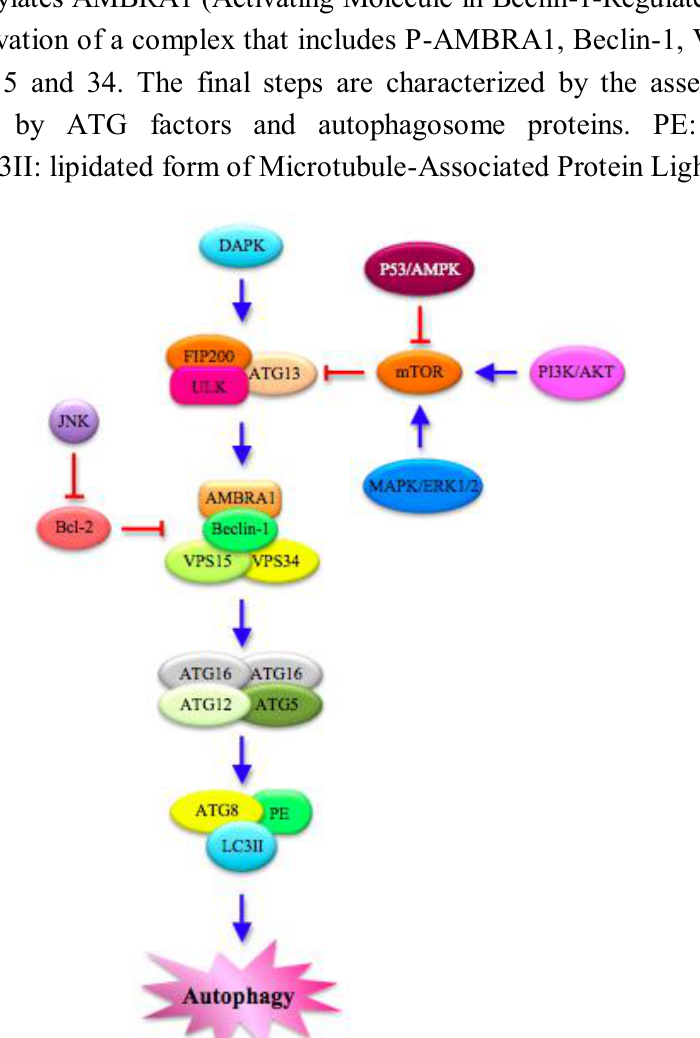
formed, which is controlled positively by UV radiation Resistance-Associated Gene (UVRAG)